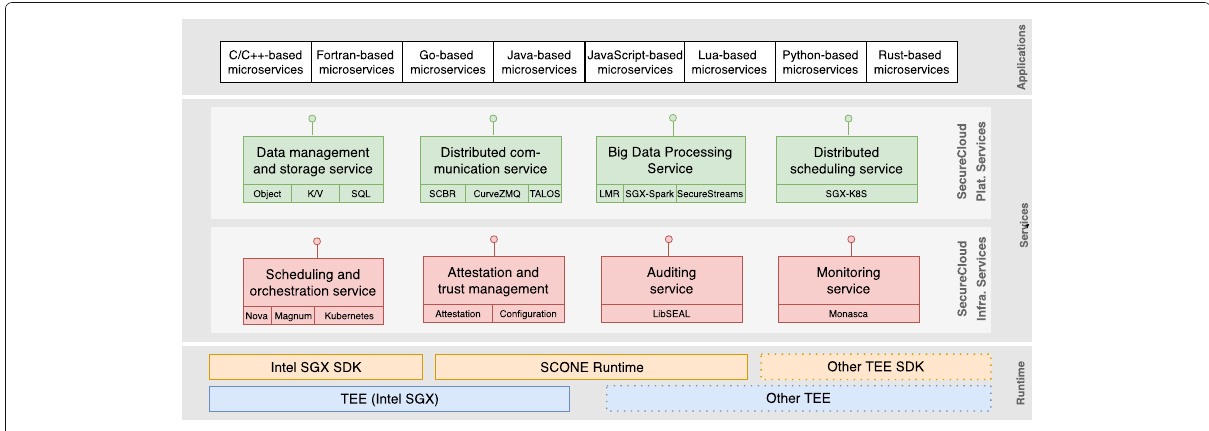
Fig. 2 Overview of the SecureCloud platform and its components